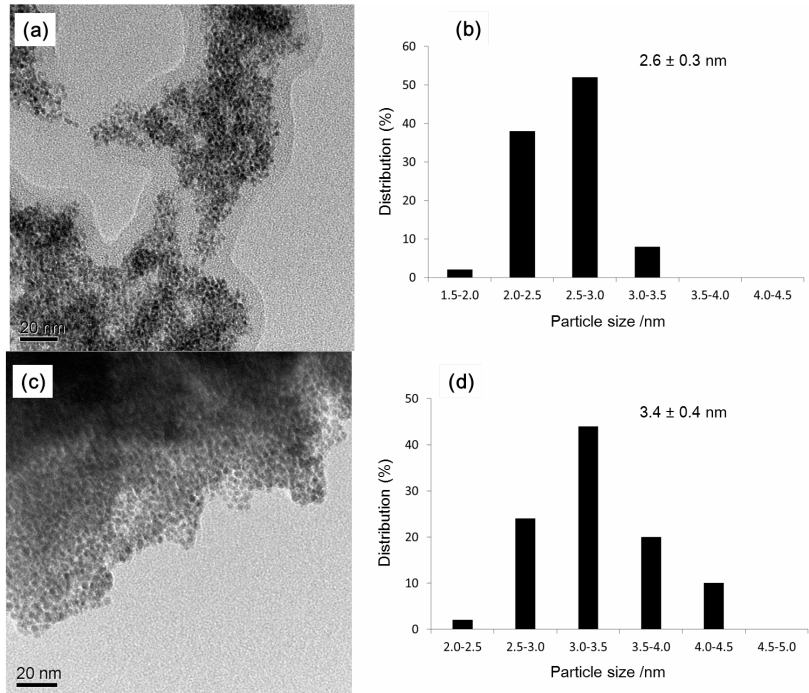
Figure 1. ( a ) TEM micrograph of PS-PdONPs (scale bar = 20 nm); ( b ) size distribution of PS-PdONPs; ( c ) TEM micrograph of recovered catalyst after fifth run (scale bar = 20 nm); ( d ) size distribution of recovered catalyst after fifth run.